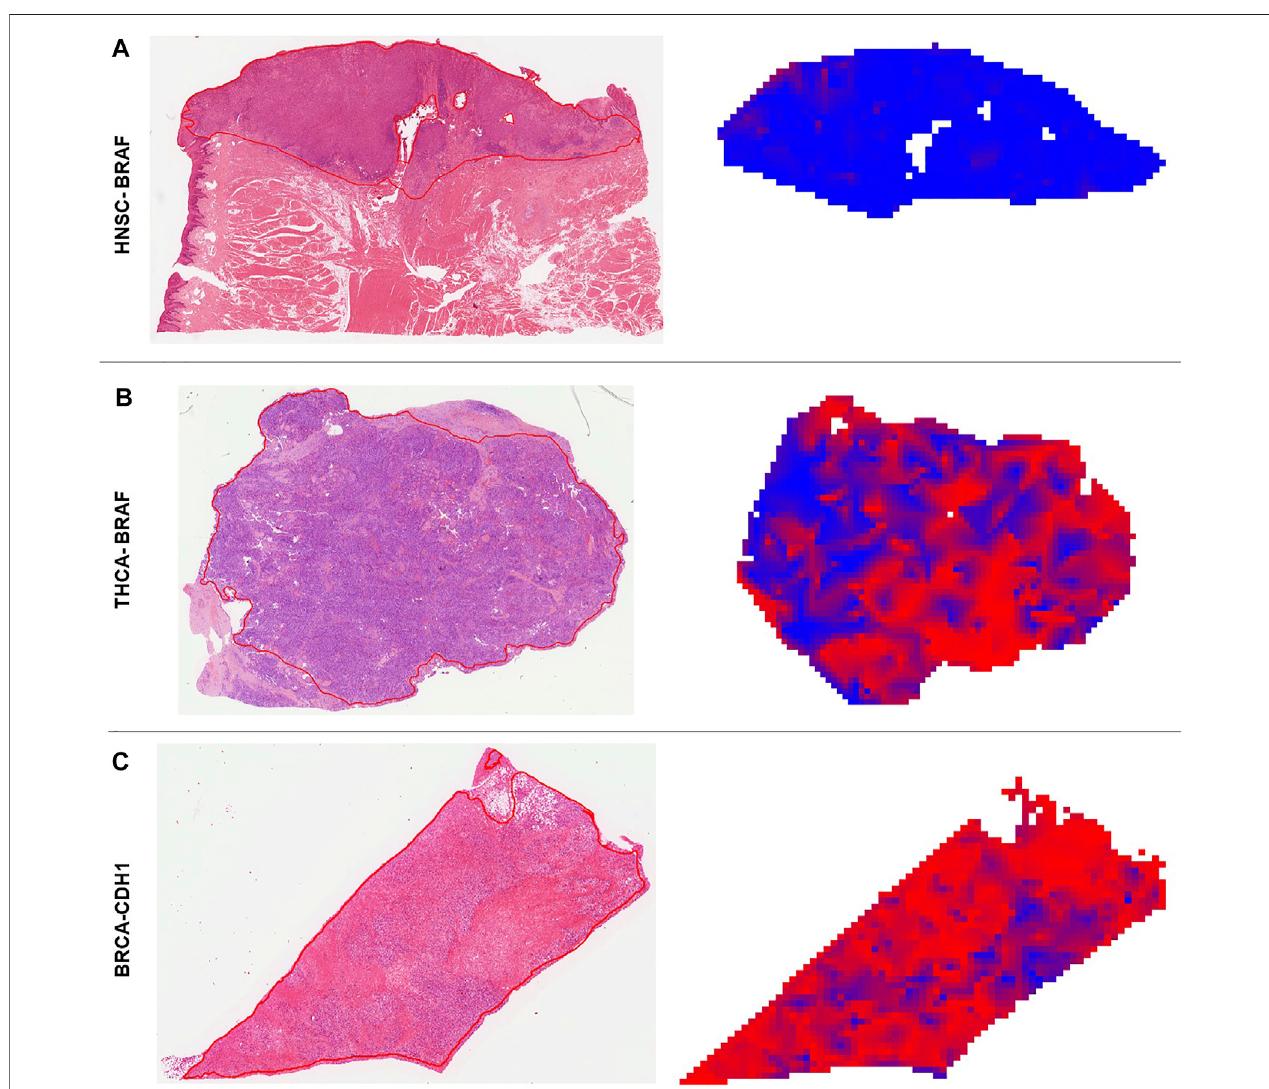
FIGURE 5 | Deep learning predicted heatmaps. Visualization of manually annotated histological slides hematoxylin & eosin (H&E) with corresponding prediction maps for altered genes. Blue areas are wild type (WT) predicted regions and red areas are identi fi ed as mutated (MUT) parts by the neural network. (A) H&E slide of a BRAF WT patient (ID: TCGA-CQ-5333) from the head and neck squamous cell carcinoma (HNSC) cohort. The homogenous blue heatmap is consistent with the wild typestatusofthepatient. (B) H&Eslideofa BRAF mutatedpatient(ID:TCGA-EL-A3H7)fromthethyroidcarcinoma(THCA)cohort.Theheatmapismorethan50% red,whichmeansthepatientwascorrectlyclassi fi edasMUT.Intermingledblueareasintumorregionsre fl ectstromaandartifactsthatdisturbtheseareas. (C) H&Eslide of a CDH1 mutated patient (ID: TCGA-PE-A5DD) ofthe breast invasive carcinoma (BRCA) cohort. The prediction heatmap shows that stroma tissue is mostly predicted as WT (blue areas condensed connective tissue) and diffuse invasive-lobular cancer is mostly red.